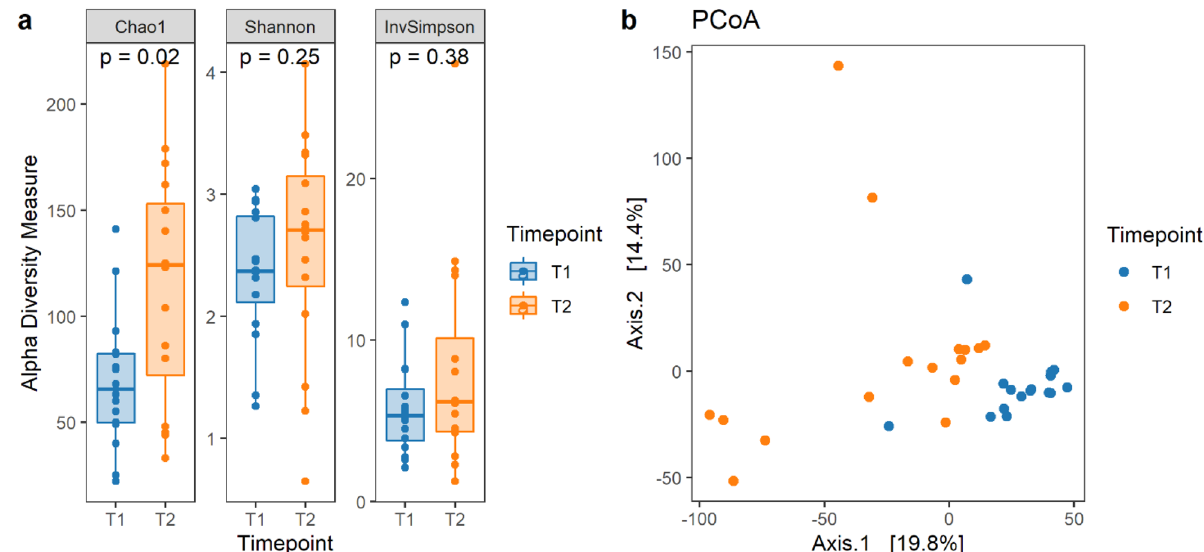
Figure 6. Descriptive plots for bacterial diversity. ( a ) Boxplots of the Chao1, Shannon and InvSImpson α-diversity for each timepoint. ( b ) Non-metric multi-dimensional scaling (NMDS) plot using a Euclidian distance matrix for the 32 samples coloured according to